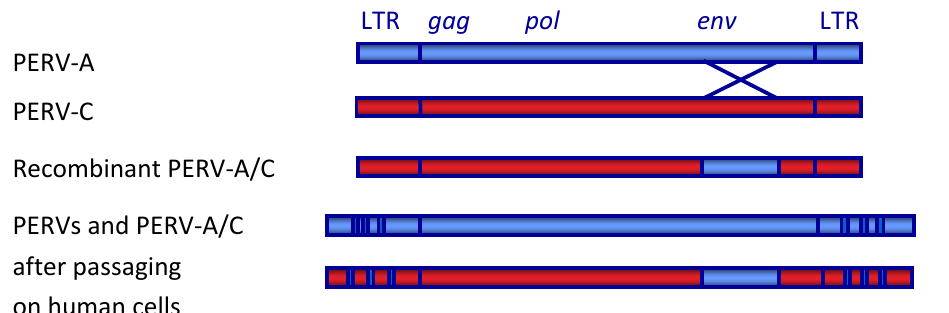
Figure 1. Schematic presentation of the genome of PERV. LTR, long terminal repeat; gag, group specific antigen; pol, polymerase; env, envelope. The recombinant PERV-A/C is the result of a recombination in the env gene spanning the receptor binding domain (RBD). During passaging of PERV-A and PERV-A/C on human cells, a multimerization of repeats in the LTR takes place [35]. 5. Host Range In Vitro and In Vivo and